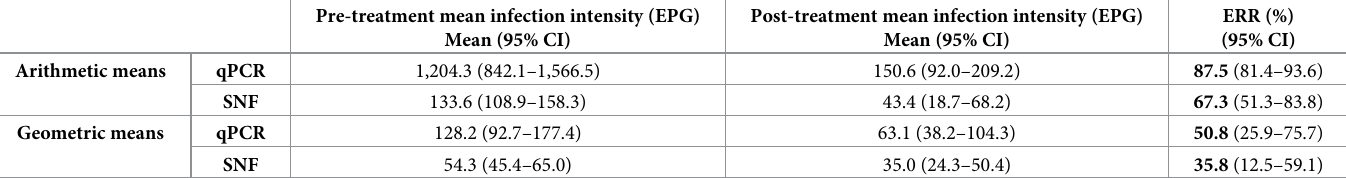
Table 4. Infection intensity values before and after albendazole treatment, and ERR as measured by qPCR for N . americanus and SNF for hookworm. Pre-treatment mean infection intensity (EPG) Mean (95%